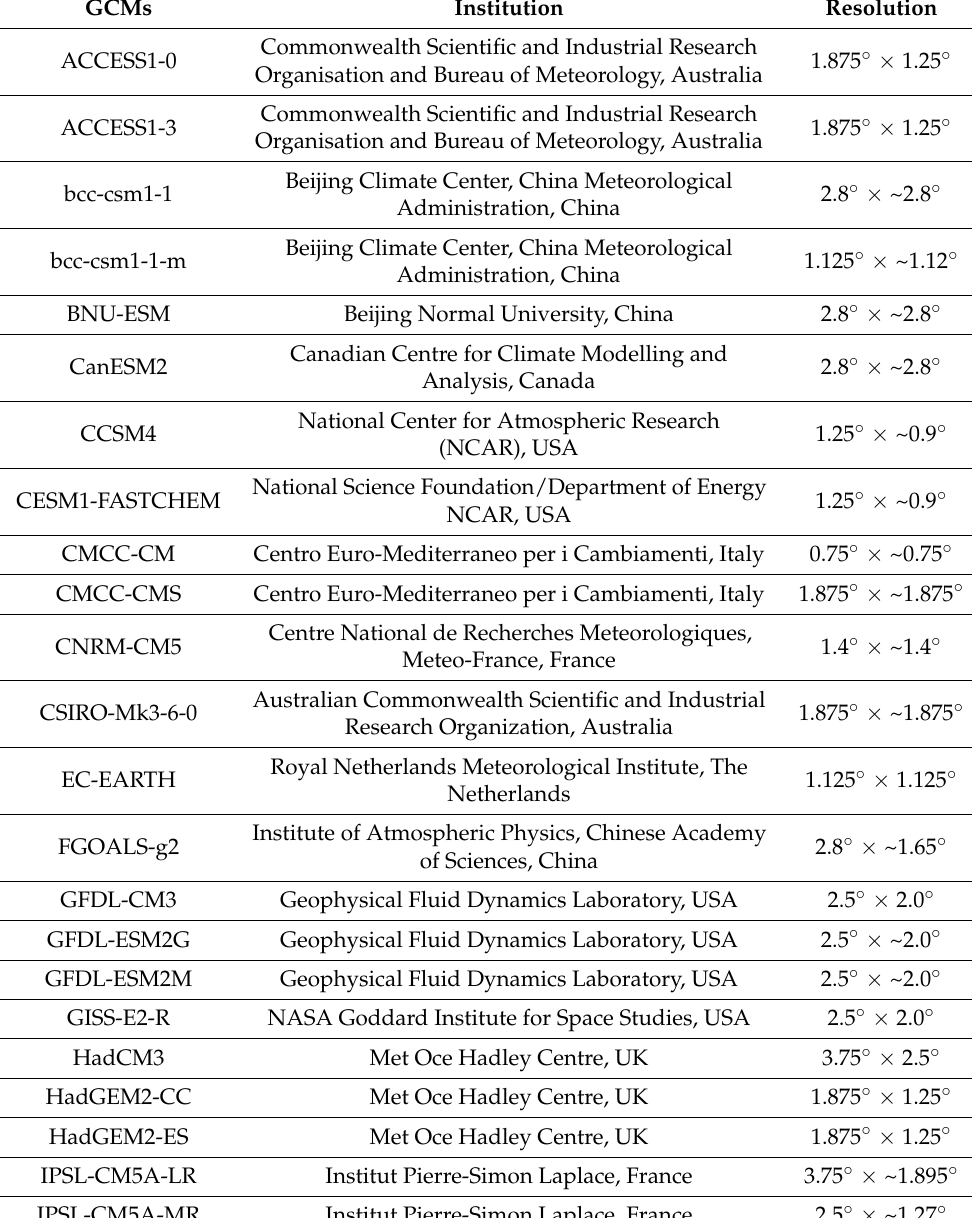
Table 1. Model identification, originating center, and atmospheric